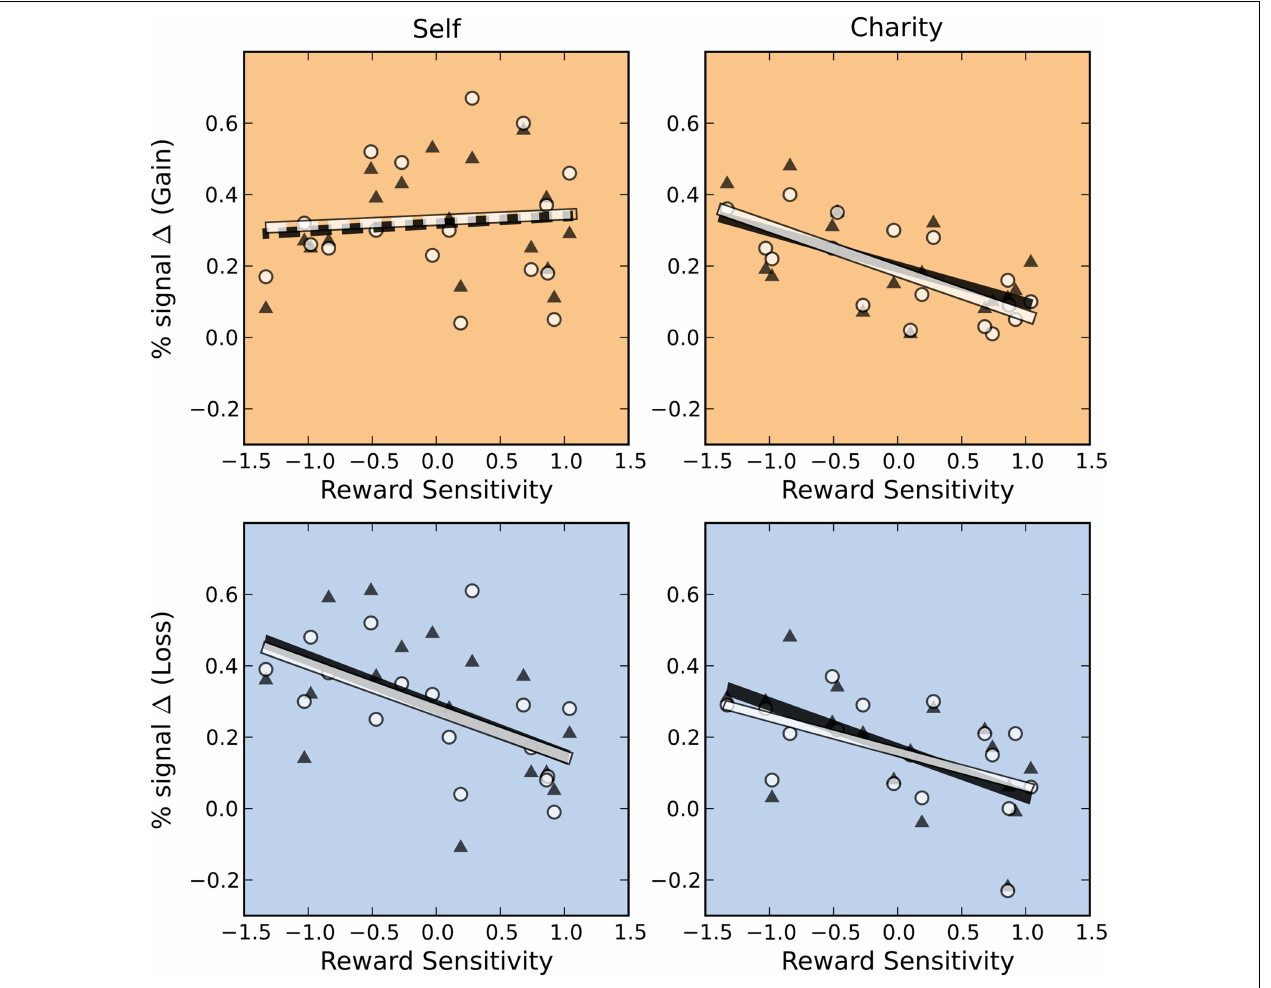
FIGURE 7 | BOLD responses in the Self-Gain condition are unrelated to reward sensitivity. BOLD responses ($4 > $0) in both the NAcc (white circle) and VTA (black triangles) were anticorrelated with reward sensitivity across subjects except in the Self-Gain condition (NAcc self-gain: r = 0.06, p = 0.81; VTA self-gain: r = 0.11, p = 0.68; NAcc charity-gain: r = − 0.72,